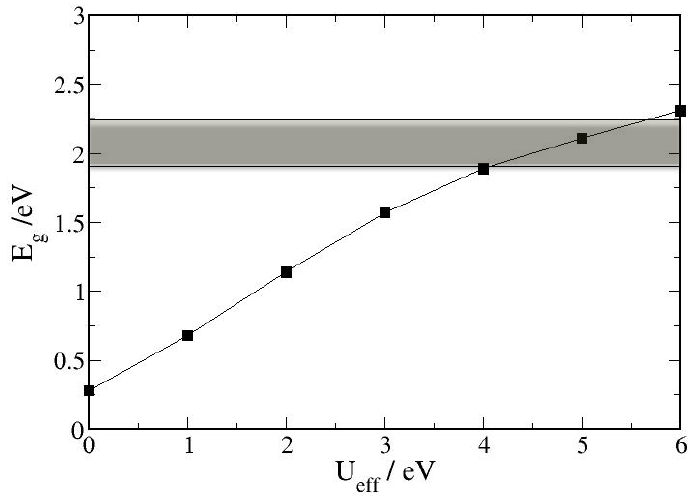
O with GGA+U = 5 eV. The Fermi level is set 2 3